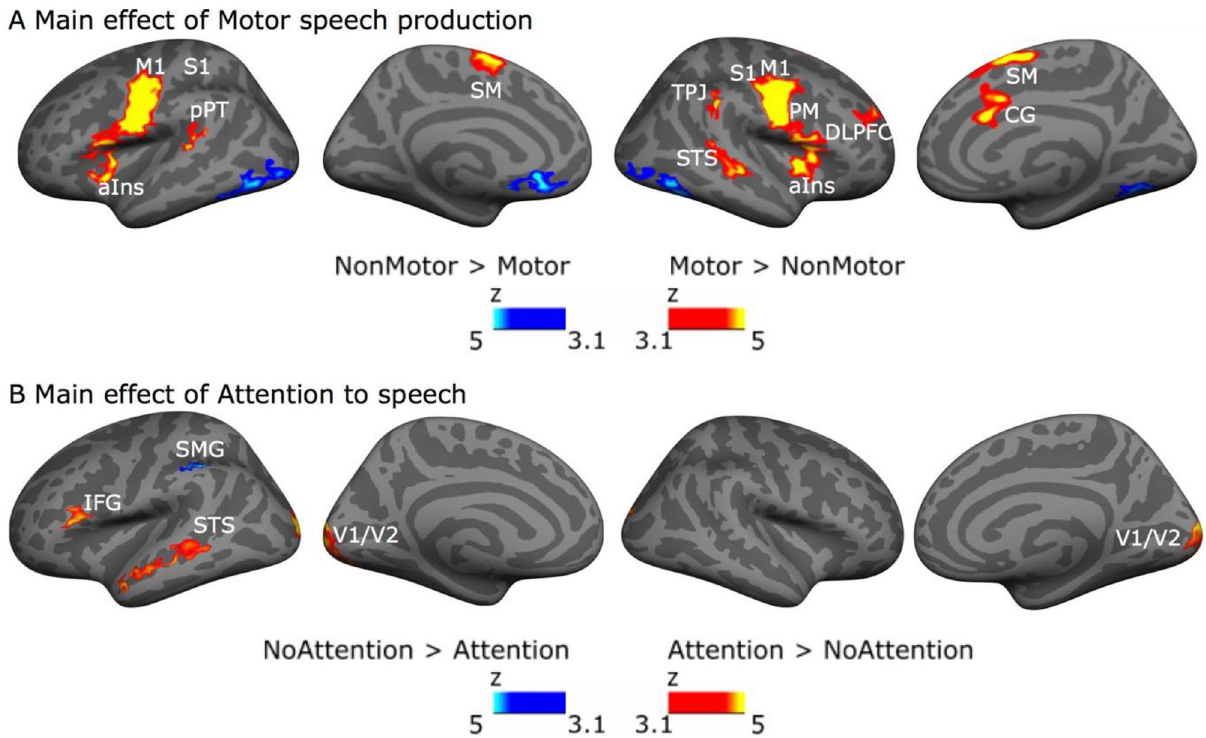
Figure 5. The omnibus ANOVA with factors Motor speech production, Attention to AV speech, Auditory quality and Visual quality revealed extensive main effects of Motor speech production and Attention to AV speech. ( A ) Significant clusters (initial cluster threshold z = 3.1; permutated cluster significance p < 0.05, FWER corrected) for the main effect of Motor speech production. Clusters where the motor tasks (shadowing and motor control task; Motor) activations were stronger than the non-motor tasks (AV speech listening and visual control task; NonMotor) are shown in red/yellow, the converse in blue/cyan. From left to right: lateral and medial views of the inflated left hemisphere and lateral and medial views of the right hemisphere (lighter gray denotes gyri and darker gray sulci). ( B ) Clusters where the tasks that demanded attention to AV speech (shadowing and AV speech listening task; Attention) activations were stronger than those during the tasks not demanding attention to AV speech tasks (motor control and visual control task; ignore) are shown in red/ yellow, the converse in blue/cyan. STS superior temporal sulcus, aIns anterior insula, IFG inferior frontal gyrus, M1 primary motor cortex, PM premotor cortex, S1 primary somatosensory cortex, V1/V2C visual area ½, SM supplementary motor cortex, TPJ temporoparietal junction, pPT posterior planum temporale, DLPFC dorsolateral prefrontal cortex, SMG supramarginal visual and motor control tasks (Fig. 5B, red/yellow). In contrast, the left supramarginal gyrus was activated more strongly during the visual and motor control tasks than during the listening and shadowing tasks (Fig. 5A, blue/ cyan), possibly because the control tasks demanded counting (see 27 ).